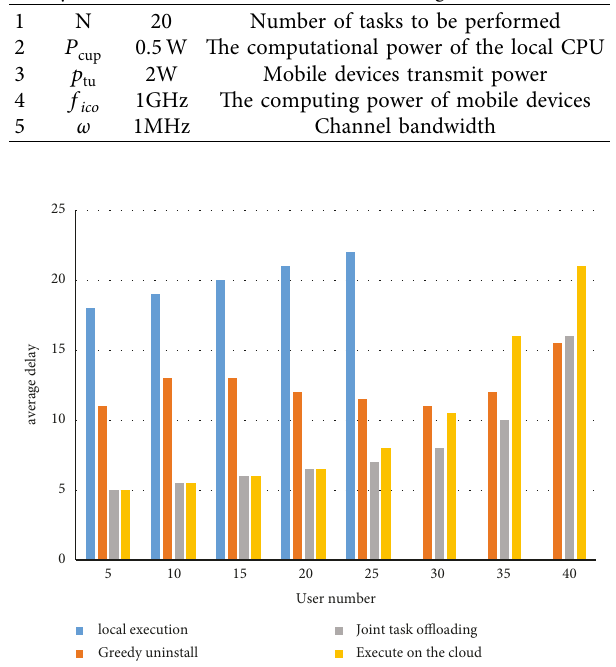
Figure 7: Average latency under different task